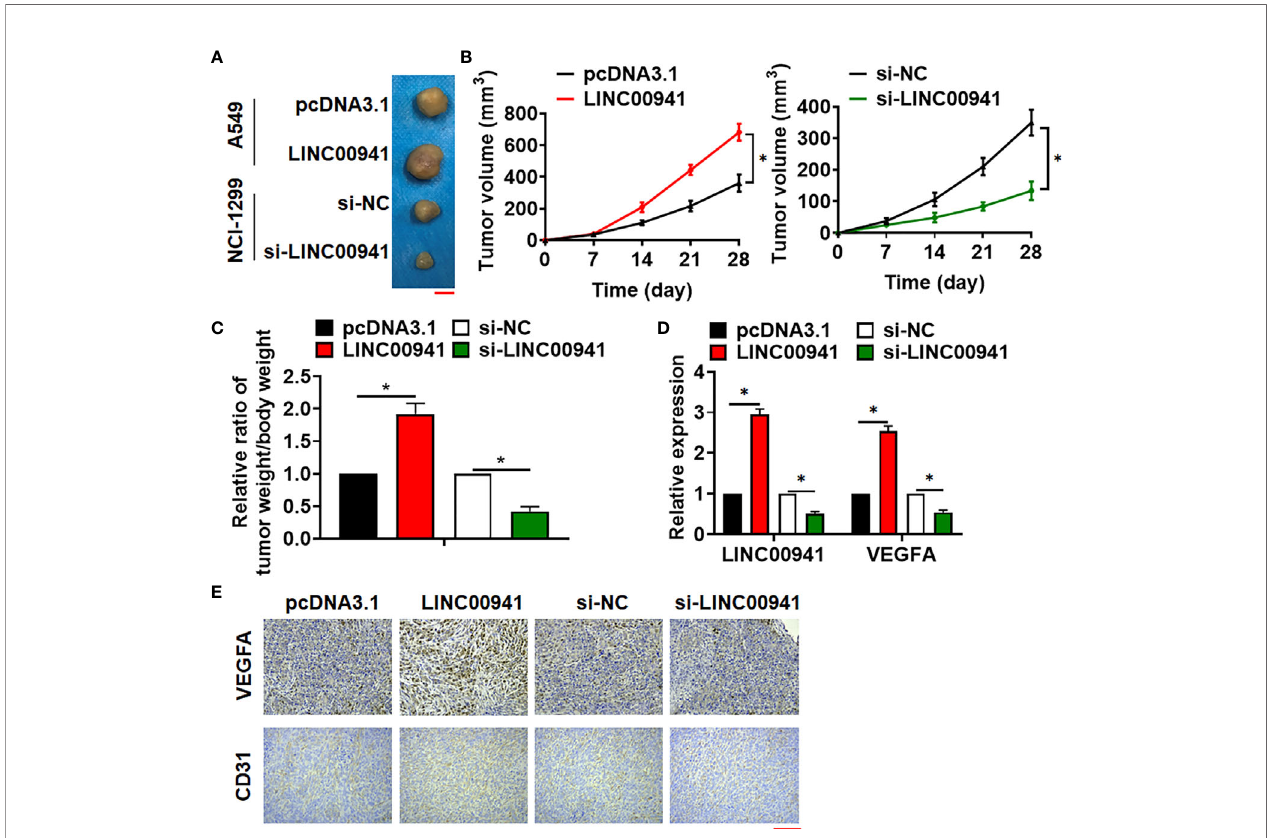
FIGURE 3 | Silencing of LINC00941 inhibited tumorigenesis of NSCLC. (A) Images of the representative excised tumors from the mice at 28 days after injection with the A549 (stably expressed LINC00941) and NCI-1299 cells (stably expressed si-LINC00941). (B) Tumor volume was measured every 7 days. (C) The ratio of tumor weigh to body weight was calculated. (D) The mRNA of LINC00941 and VEGFA in isolated tumors were detected by qRT-PCR. (E) IHC staining used to detect VEGFA and CD31 expression of isolated tumors. Data are mean ± SD; *P < 0.05. All experiments were repeated three